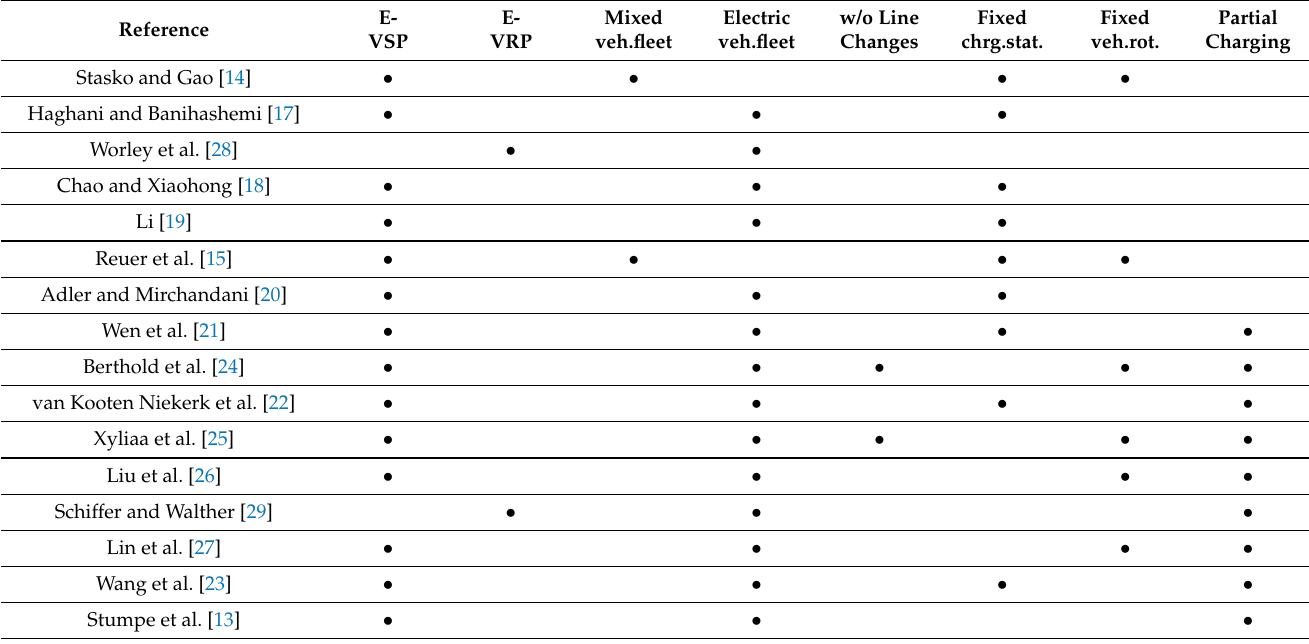
Table 1. Overview of the main characteristics of related